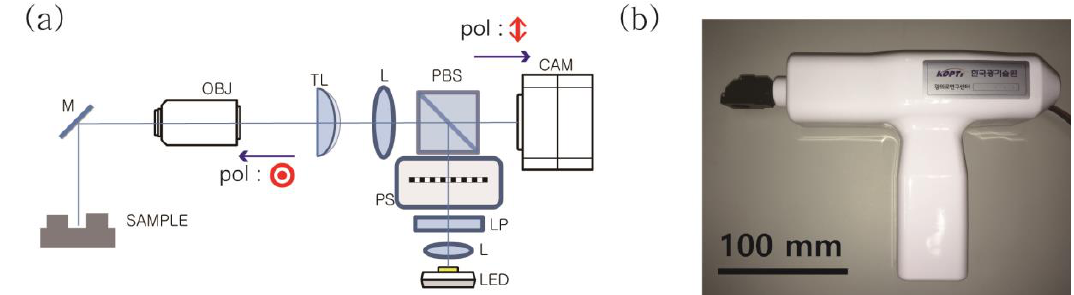
Figure 1. ( a ) Schematic of the experimental setup. The structured light pattern, which was generated by a Ronchi ruling, focused on the sample. The scattered light from the sample was collected by an objective lens and recorded by a camera. The ⊙ and arrow signs (red) represent the polarization of illuminated and scattered light, respectively. (M: mirror, OBJ: objective lens, TL: tunable lens, L: lens, PBS: polarizing beam splitter, CAM: camera, PS: piezo stage, LP: linear polarizer). ( b ) Picture of the three-dimensional scanning apparatus. The dimensions of the apparatus are 275 mm × 176 mm × 72 mm. Scale bar: 100 mm.